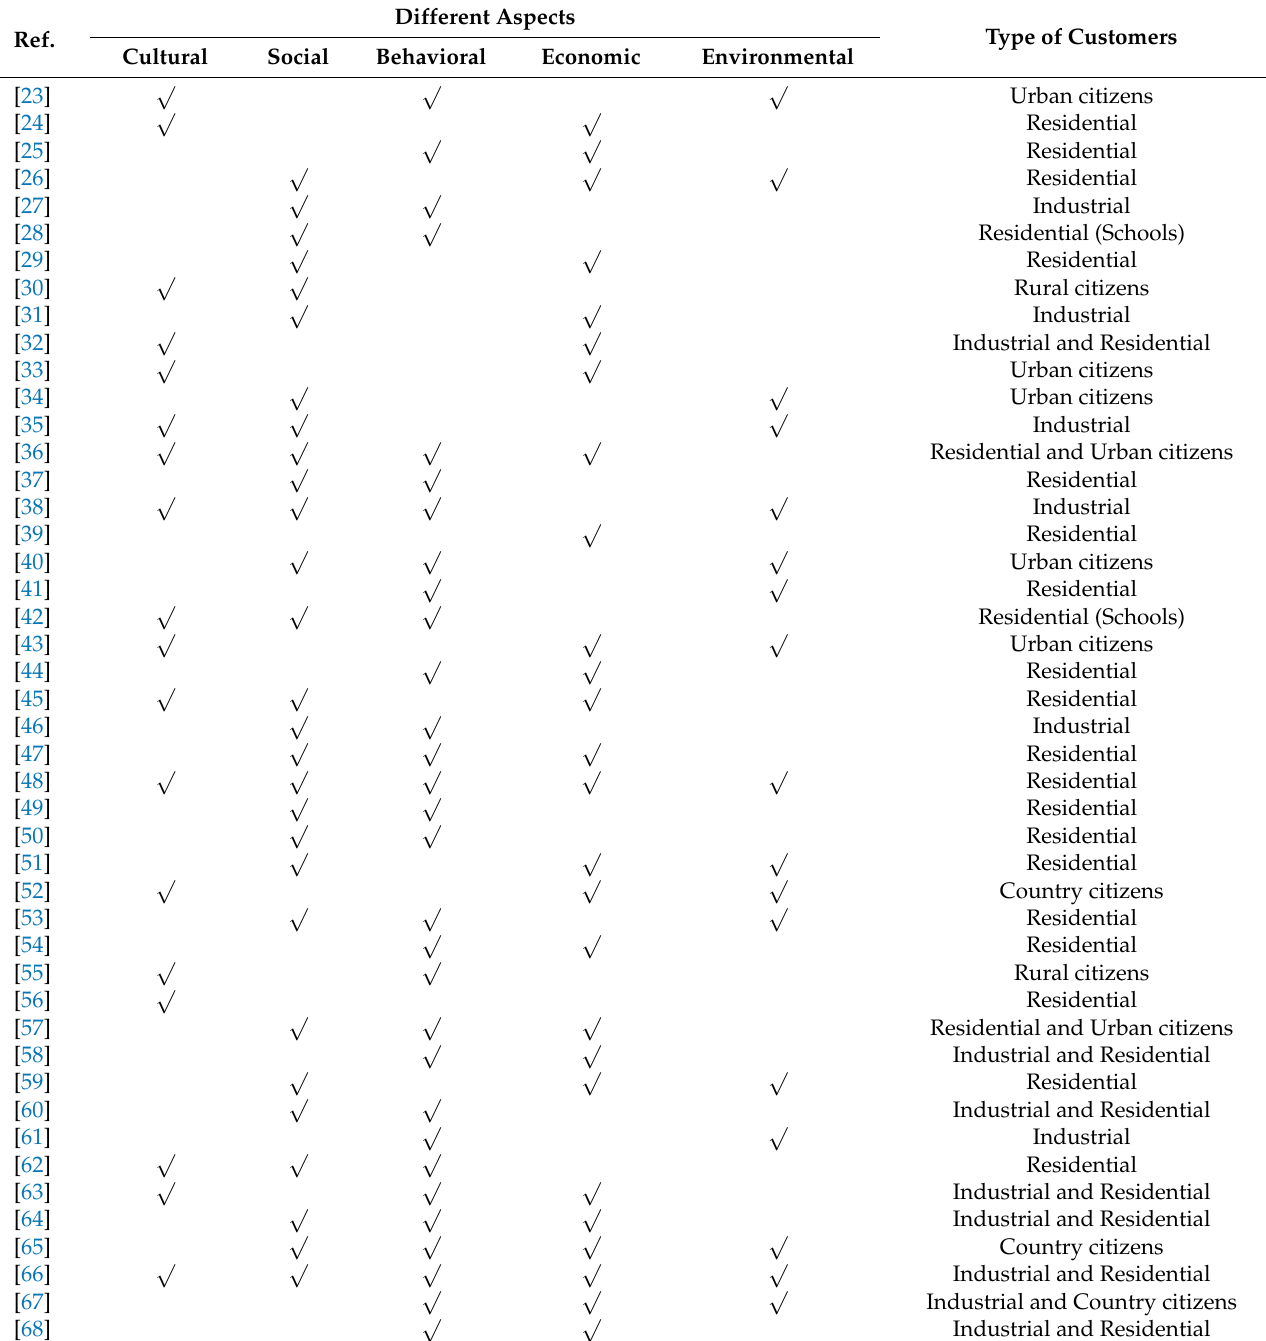
Table 1. Taxonomy of the studies from five different